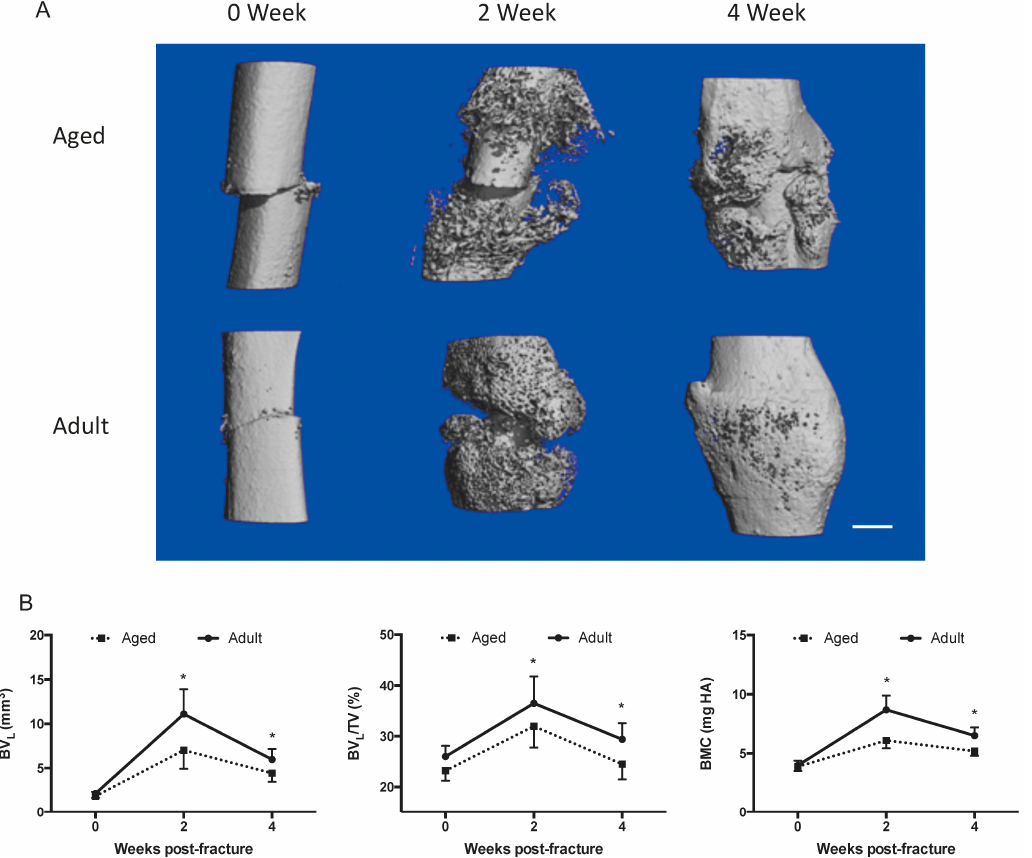
Figure 1. Fracture healing in aged and adult female mice ( A ) representative three-dimensional (3D) images of the fracture calluses in adult and aged groups at each time point after fracture; ( B ) time course changes in low-density bone volume (BV L ) ( left ), low-density bone volume fraction (BV L /TV) ( middle ), and bone mineral content (BMC) ( right ) of the callus after fracture in each group; n = 3. Note: scale bar = 1 mm. * p < 0.05 for “Aged” vs. “Adult”.